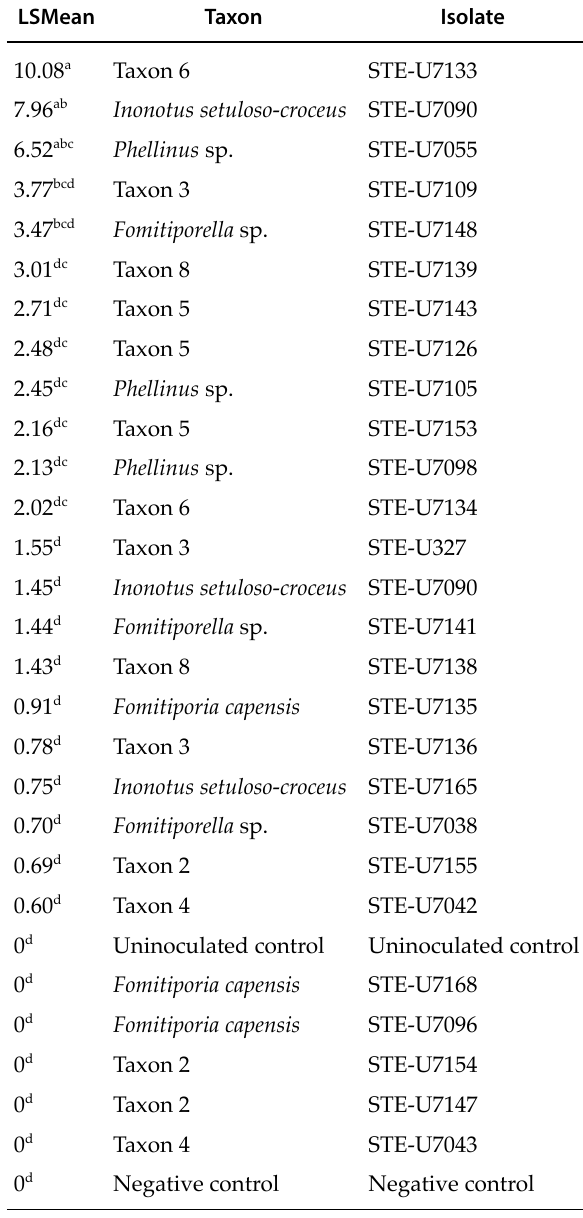
Table 3. Mean lengths of brown discoloured lesions (mm) produced in the cordons of Mourvédre vines inoculated with representative isolates of Hymenochaetales taxa.